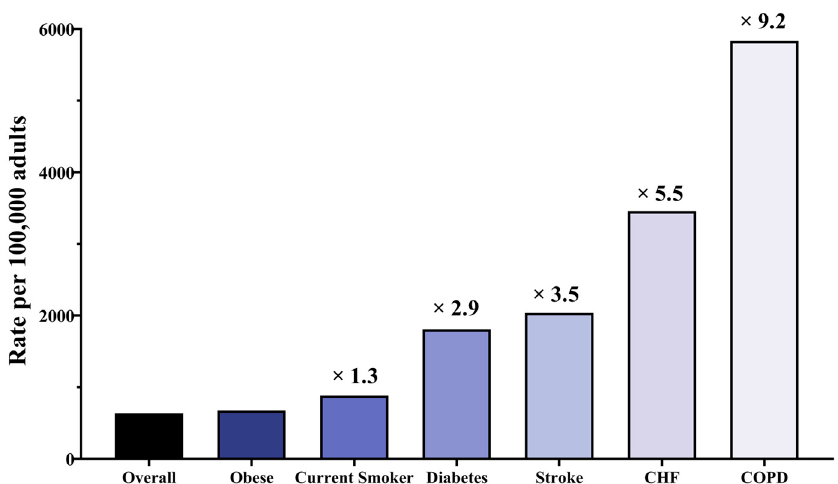
Figure 1. The impact of comorbidities on the incidence of patients hospitalized with community- acquired pneumonia (CAP). CHF: congestive heart failure; COPD: chronic obstructive pulmonary